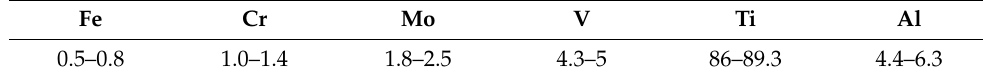
Table 2. Chemical composition of alloy VT23.